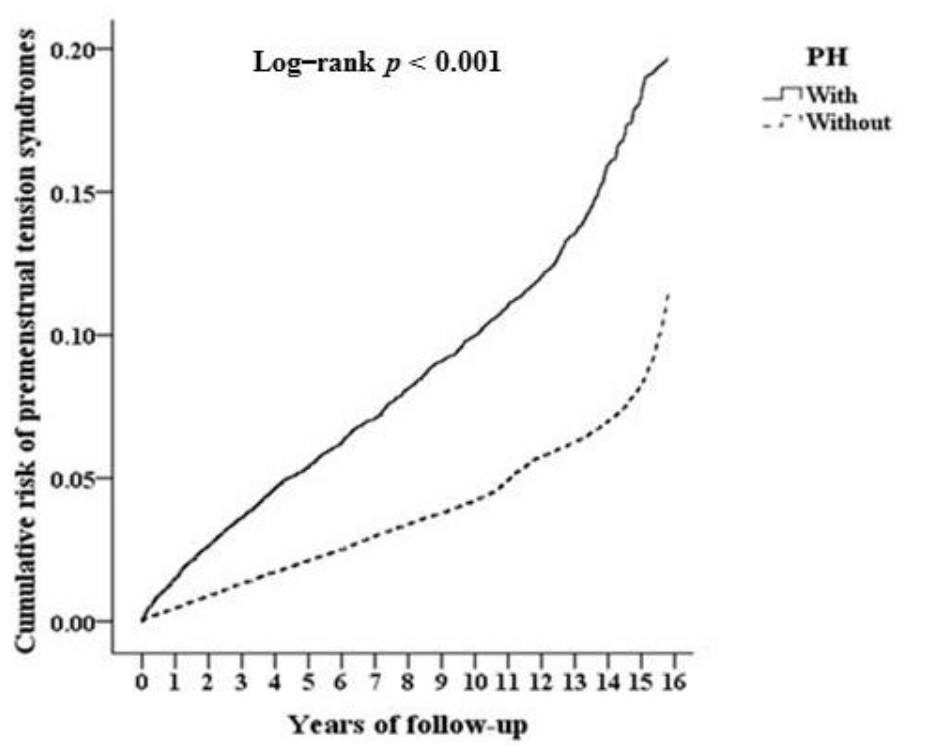
Figure 2. Kaplan–Meier analysis of the cumulative risk of premenstrual syndrome stratified by PH with the log-rank test.